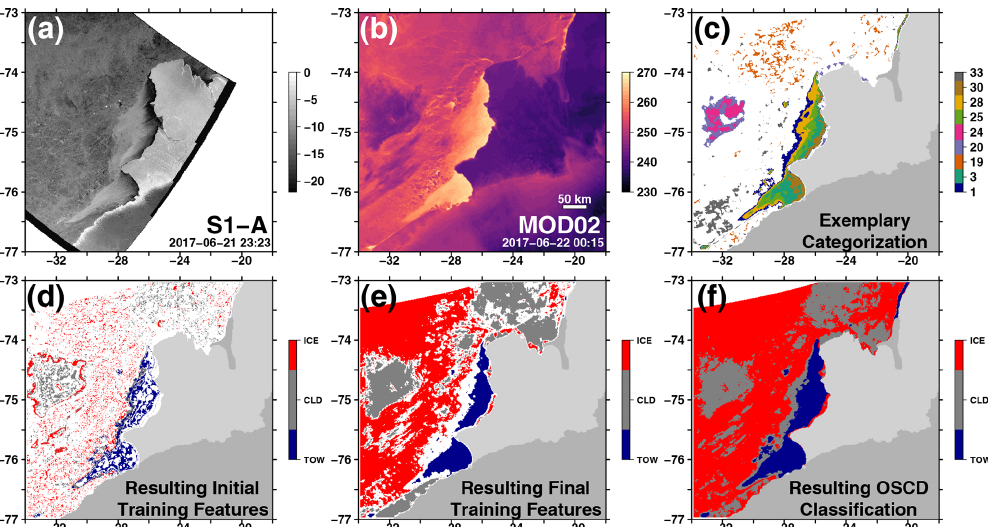
Figure 3. Exemplary generation of labeled training data with a reference Sentinel-1 A/B calibrated-backscatter image (in dB; a ), MOD02- derived ice-surface temperature (in K; b ), an exemplary subset of 9 clusters out of the 35 total clusters from the used autoencoder and fuzzy c -means clustering before (c) and after (d) manual categorization and quality control ( d ; thin-ice or open-water, TOW; clouds, CLD; sea ice, ICE), the final training based on the generalizing NN (e) , and the resulting classification based on the final OSCD (open-water–sea-ice–cloud discrimination) algorithm (f) . Land-ice (dark gray) and ice-shelf (light gray) overlays originate from RTopo-2 (Schaffer et al., 2016). In (c) , clusters 20 and 24 were categorized as cloud; clusters 1, 3, 25, 28, and 30 were categorized as open water and/or thin ice; and clusters 19 and 33 were categorized as sea ice. Please note that the date format in this figure is year month day